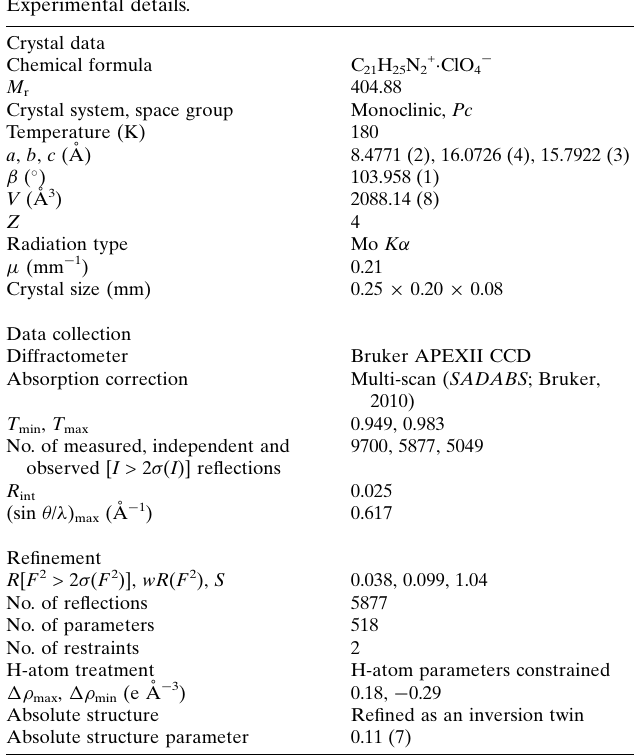
Table 2 Experimental details.